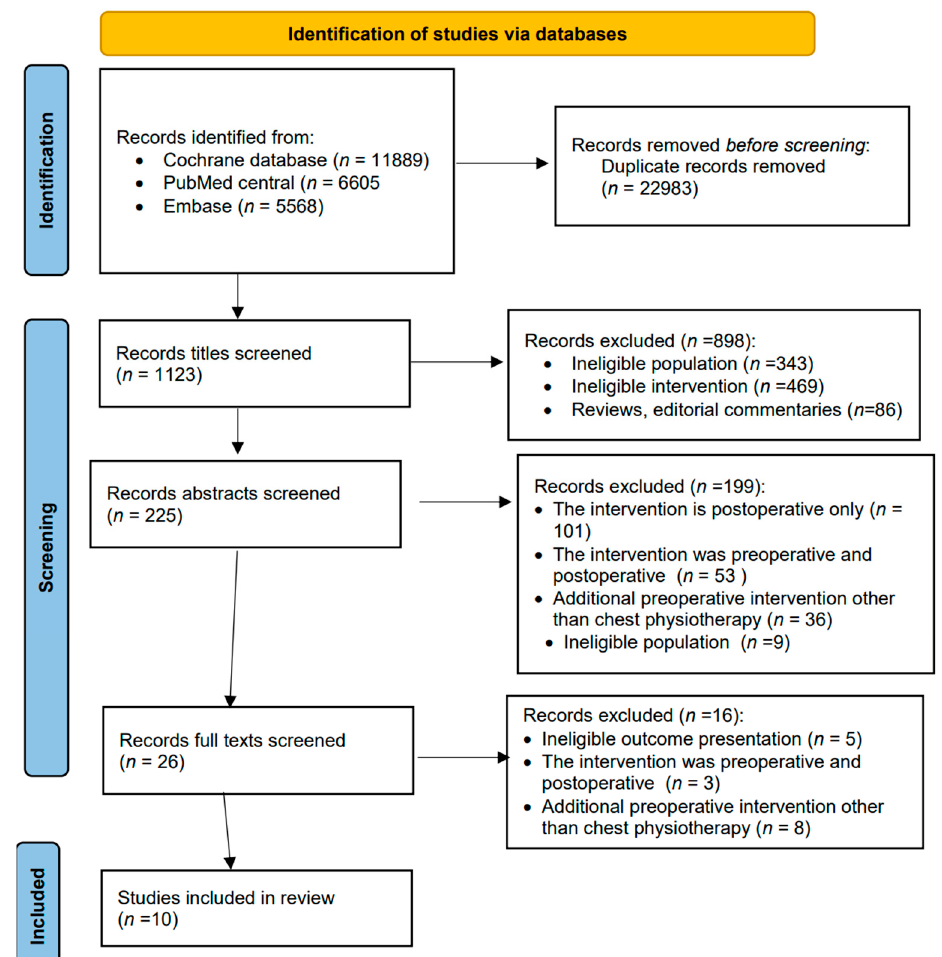
Figure 1. PRISMA study selection flow chart. The included articles were published from 2006 to 2019. The populations were pa- tients scheduled for elective CABG/cardiac surgery in the Netherlands, Turkey, Taiwan, Iran, Brazil, Pakistan, and China (Table 1). Table 1. The location and design of the included studies.